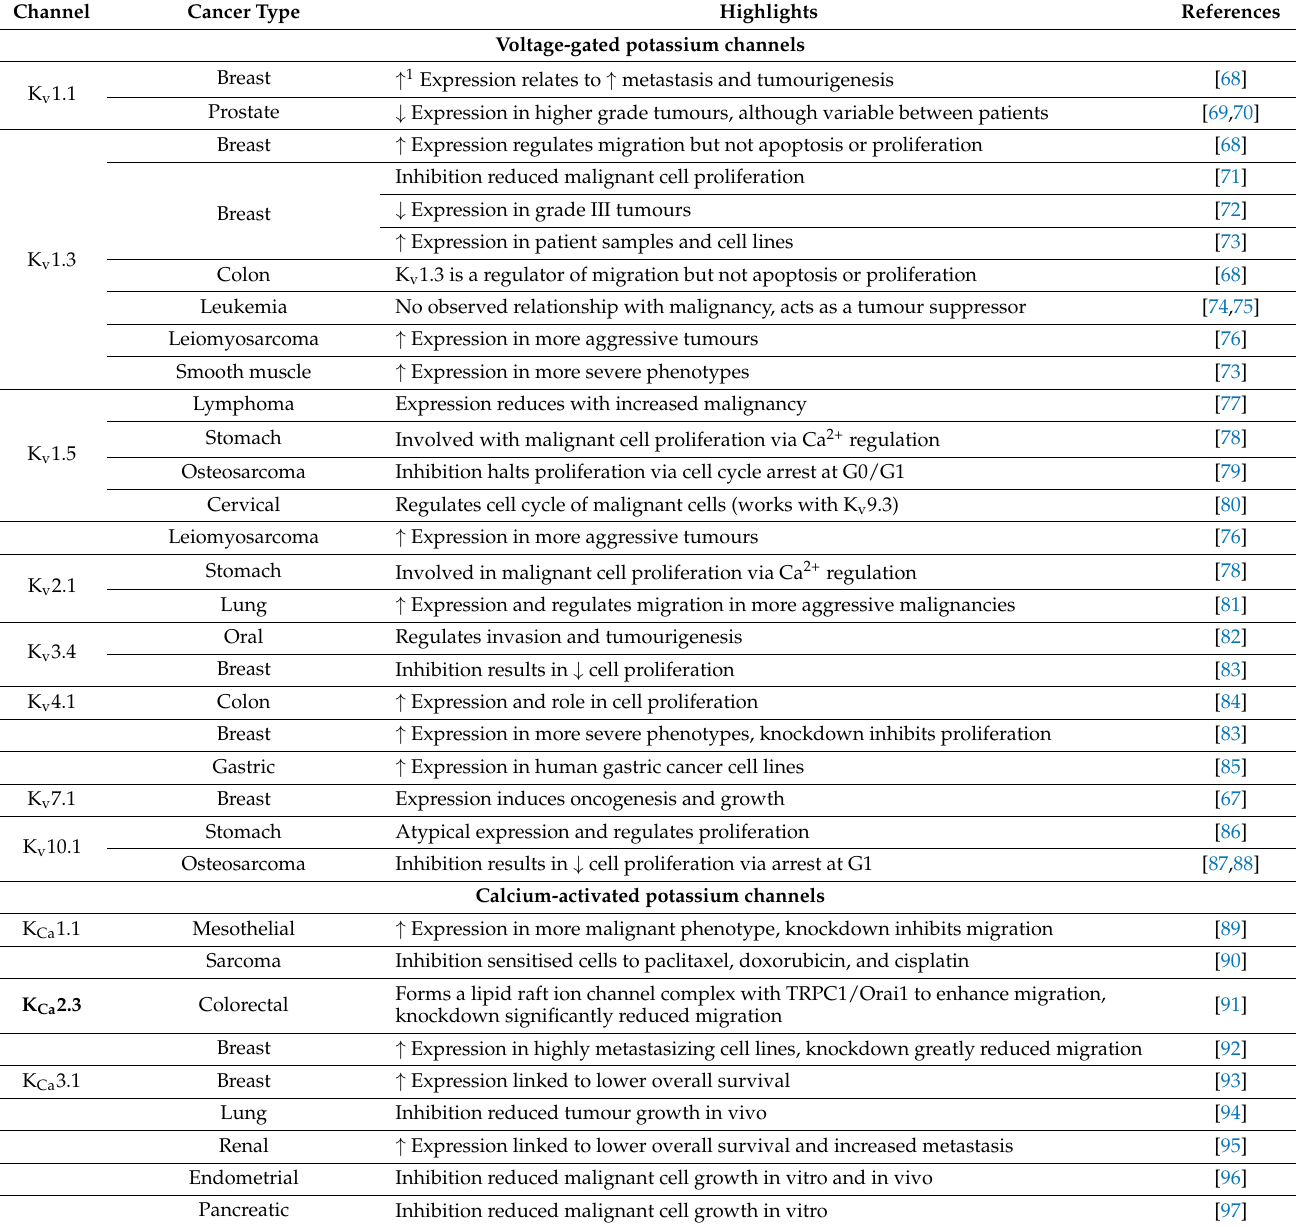
Table 1. Potassium ion channels in non-CNS